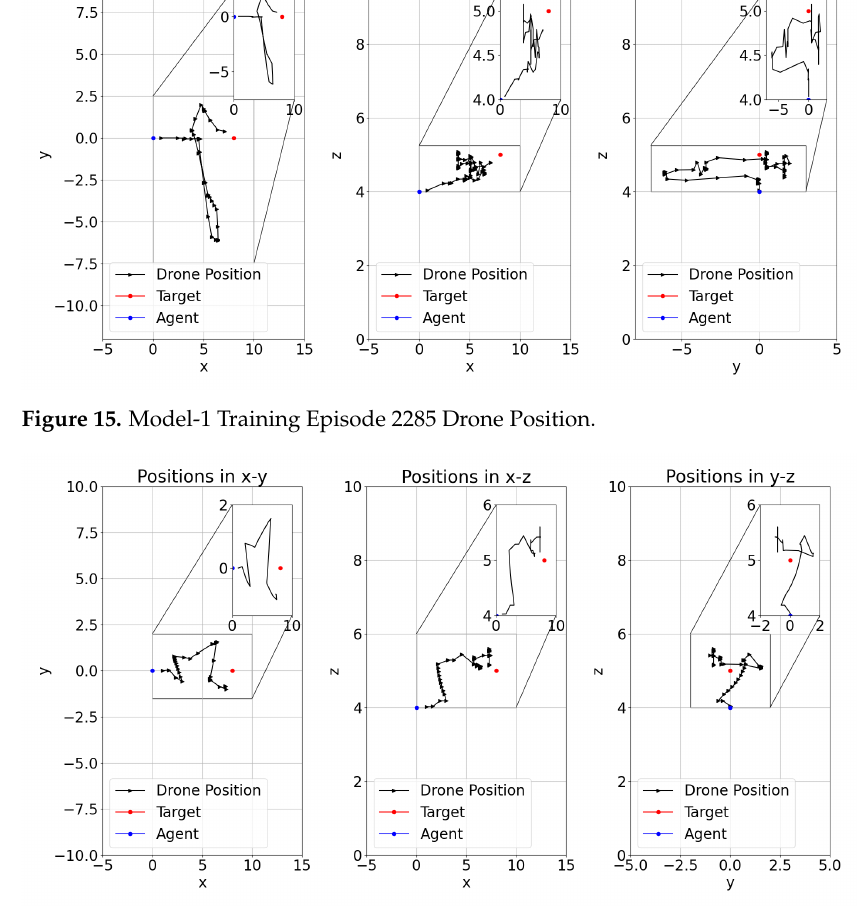
Figure 16. Model-8 Training Episode 2666 Drone